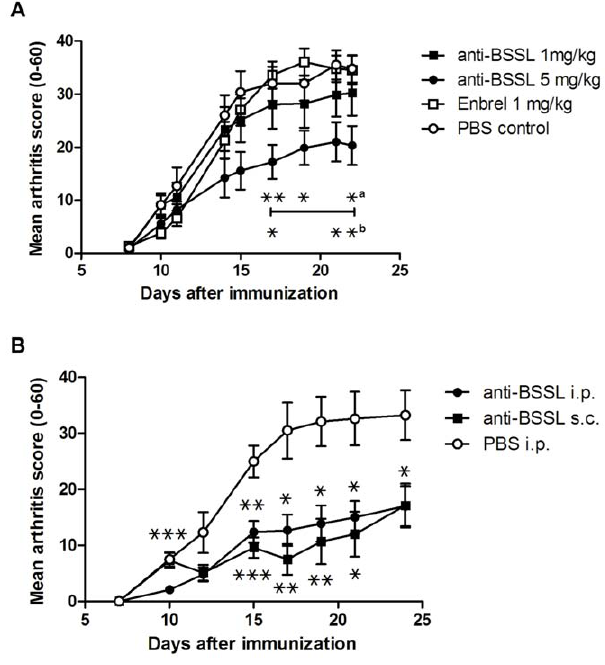
Figure 7. Prevention of PIA in rats by BSSL neutralizing antibodies. DA male rats were immunized with pristane on day 0 to induce arthritis. Rats were randomized to receive different treatments on three separate occasions (day 5, 10, and 15) as follows: (A) Four groups of rats (n=10 each) were treated with i.p. injection of either CDV15 antibody 1 mg/kg, CDV15 antibody 5 mg/kg, etanercept 1 mg/ kg, or PBS (placebo control). (B) Three groups of rats (n=10 each) were treated with one of the following: i.p. injection of CDV15 antibody 5 mg/kg, s.c. injection of CDV15 antibody 5 mg/kg, or PBS (i.p. injection). Arthritis development was followed by clinical scoring 2–3 times per week for 23 or 24 days after initial pristine injection. Mean scores of arthritis severity are shown. Error bars indicate 6 SEM. ??? =p , 0.05; ??? =p , 0.01; ??? =p , 0.001.